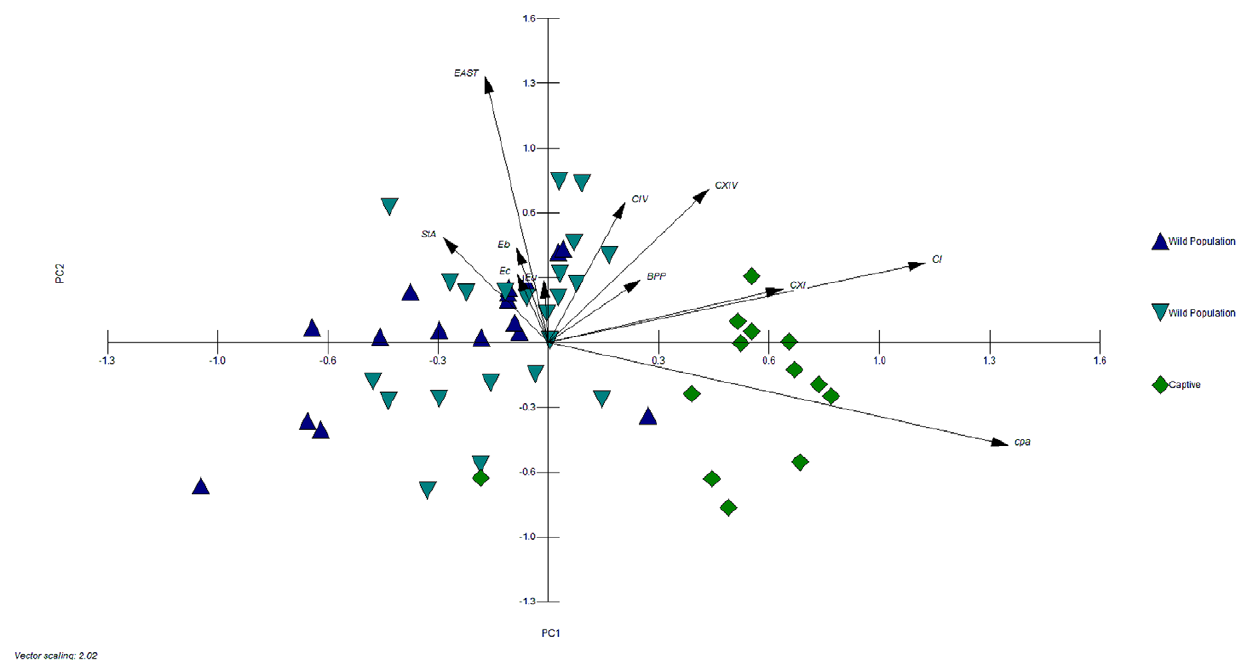
Figure 3. Correlation of housing conditions and stability of fecal bacterial communities in grizzly bears. Score and loading biplot indicating the correlation between habitat, fecal microbiota, diet, and enteric pathogens of individual wild (W1, W2, W5, and W6) and captive grizzly bears (C1, C2). The first two principal components PC1 (x-axis) and PC2 (y-axis) account for 43% of the total variance. Variables with low weights are not displayed. The three populations are indicated by colours and symbols (population 1, blue triangle; population 2, turquoise inverse triangle; population, 3 green square). Eu, total Eubacteria; Eb, Enterobacteriaceae ; Ec, Enterococci; BPP, Bacteroides-Prevotella-Porphyrmonas ; CI, Clostridium cluster I; CIV, Clostridium cluster IV; CXI, Clostridium cluster XI; CXIV, Clostridium cluster XIV; EAST, heat-stable enterotoxin; STa, shiga-like toxin A gene; cpa, C. perfringens alpha toxin gene A.